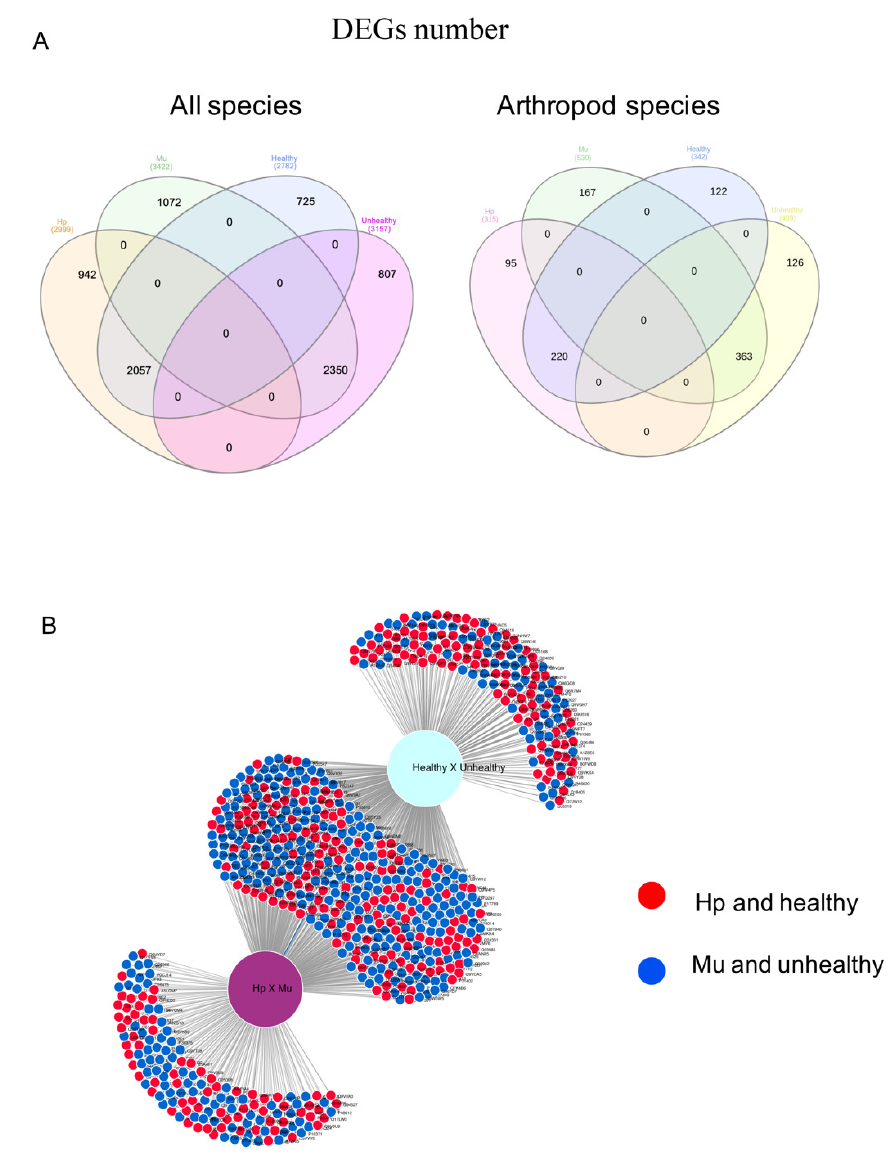
Figure 7. The union of Differentially Expressed Genes (DEGs) identified for hepatopancreas (Hp) and muscle (Mu) tissues and healthy and unhealthy conditions after WSSV (White Spot Syndrome Virus) exposure in Litopenaeus vannamei . ( A ) The numbers are shown for BLASTx hits in all species (left) and arthropod species (right). The Venn diagrams were drawn in InteractVenn [45] website (http://www.interactivenn.net). ( B ) The representation of DEGs in arthropod species. In the central area of the figure, the genes expressed simultaneously in hepatopancreas and healthy shrimps are represented by red circles and the genes expressed simultaneously in muscle and unhealthy shrimps by blue circles. Note that there are no genes in common to muscle and healthy, and hepatopancreas and unhealthy shrimps; otherwise, there would be circles highlighted in a third color in the central part of the figure. Image drawn using Di Venn [46] website (https://divenn.noble.org).